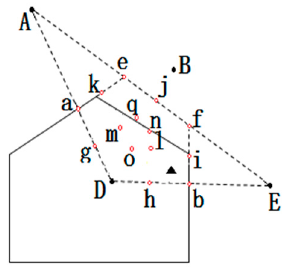
Figure 9. Virtual reference points.